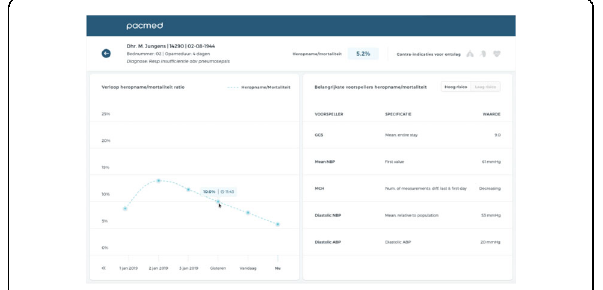
Fig. 1 (abstract 001497). See text for description